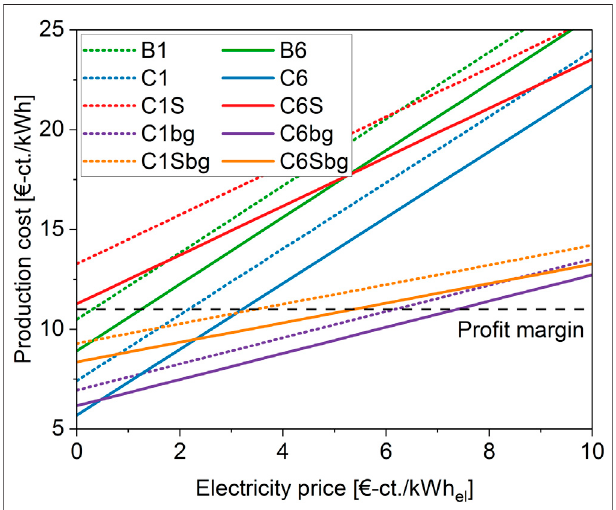
FIGURE 8 | Production cost in cents per kWh of biomethane as a function of the electricity price for each considered process. The pro fi t margin is indicated as line at 11 € -ct/kWh biomethane , which indicates the selling price for renewable gas.